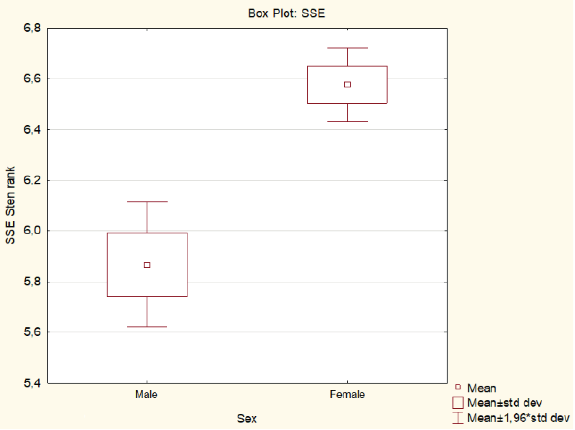
Figure 2. The differences of emotion-oriented styles of coping rank between sexes. Box Plot.